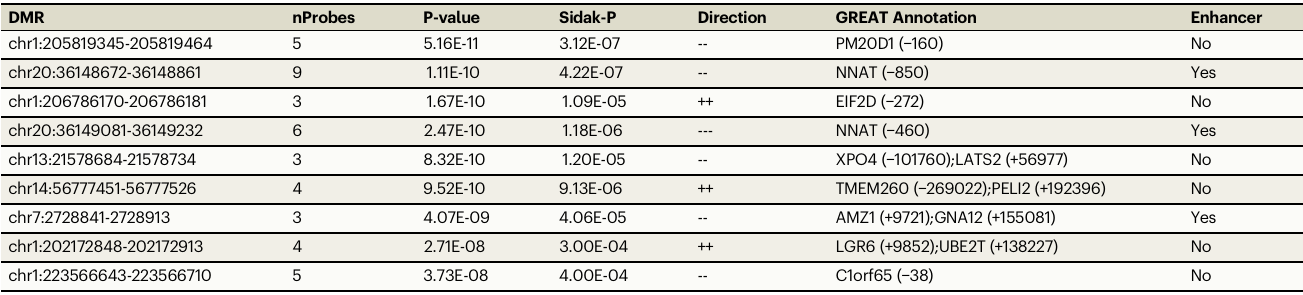
Table 2 | In epigenome-wide meta-analysis of blood DNA methylation in ADNI and AIBL datasets, comb-p software identi fi ed 9 DMRs in the Alzheimer ’ s disease (AD) vs. cognitive normal groups comparison at 5% Sidak P- values adjusted for multiple comparisons, which were then annotated using the GREAT software and the enhancer regions described in Nasser et al. (2021) study (PMID: 33828297) DMR nProbes P-value Sidak-P Direction GREAT Annotation